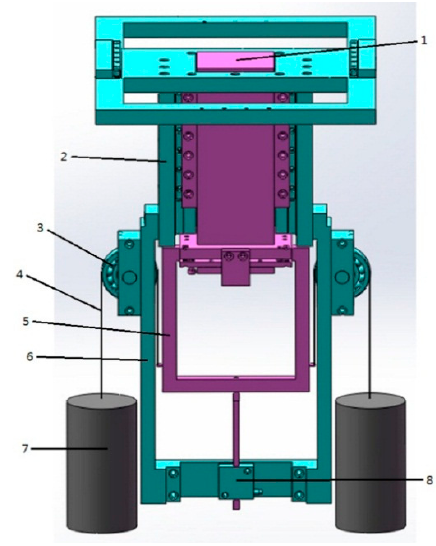
Figure 4. Schematic structure of Z ‐ stage deadweight balance system. 1: Z ‐ stage, 2: Y ‐ stage 3: Pulley, 4: Steel strip, 5: Support frame, 6: Outer frame (It is fixed with Y stage), 7: Counterweight, 8: Linear